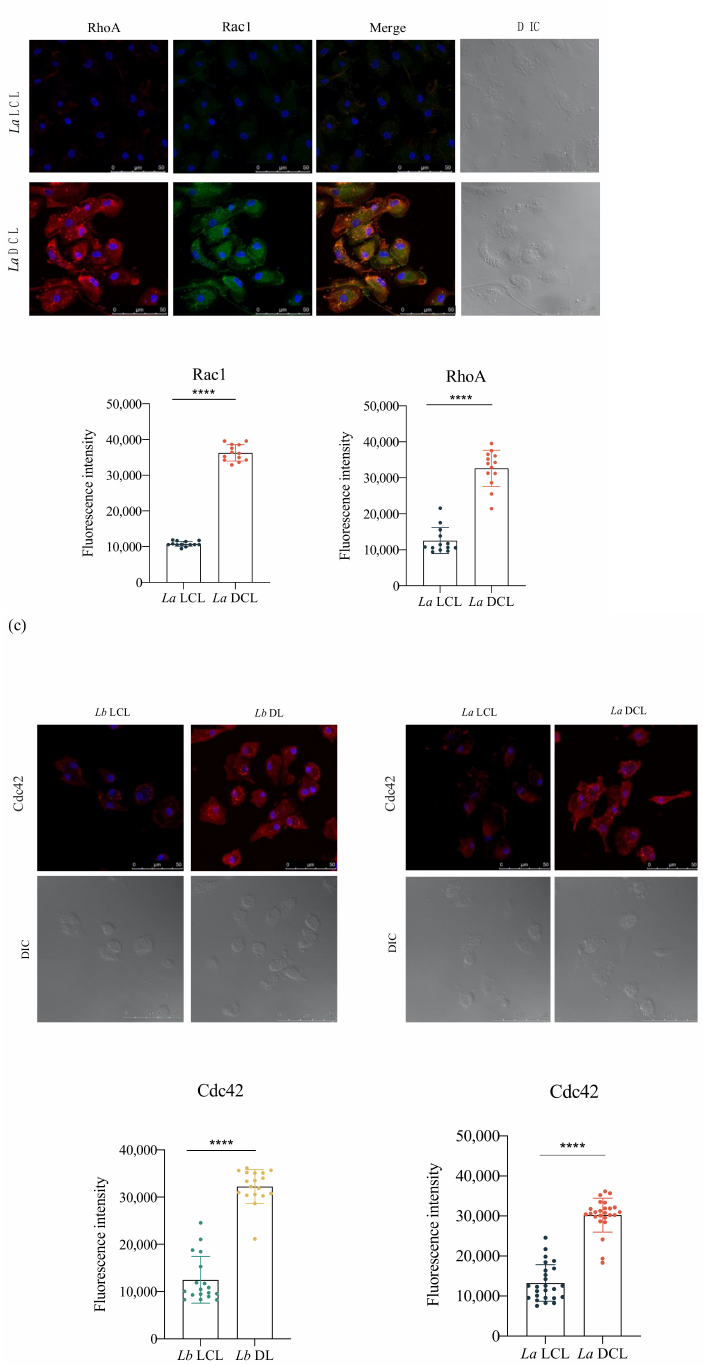
Figure 7. Lb DL and La DCL isolates induce actin polymerization in hDC. Effects of Leishmania infection using isolates obtained from patients with localized or disseminated forms on Rac1, RhoA and Cdc42 protein levels. hDCs were infected with Lb (LCL) , Lb (DL), La (LCL) or La (DCL) and stained with phalloidin, anti-Rac1, anti-RhoA or anti-Cdc42. ( a ) Fluorescence intensity of phalloidin labeling in hDCs infected with Lb (LCL), Lb (DL), La (LCL) or La (DCL). ( b ) Fluorescence intensity of Rac1 and RhoA following Lb (LCL), Lb (DL), La (LCL) and La (DCL) infection. ( c ) Fluorescence intensity of Cdc42 following Lb (LCL), Lb (DL), La (LCL) and La (DCL) infection. Fluorescence intensity quantified in 30 cells from each group. Red: anti-Rac1, anti-RhoA or anti-Cdc42; blue: DAPI (cell nuclei); grayscale, DIC. **** p < 0.001 (Student’s t -test). Data are representative of three independent